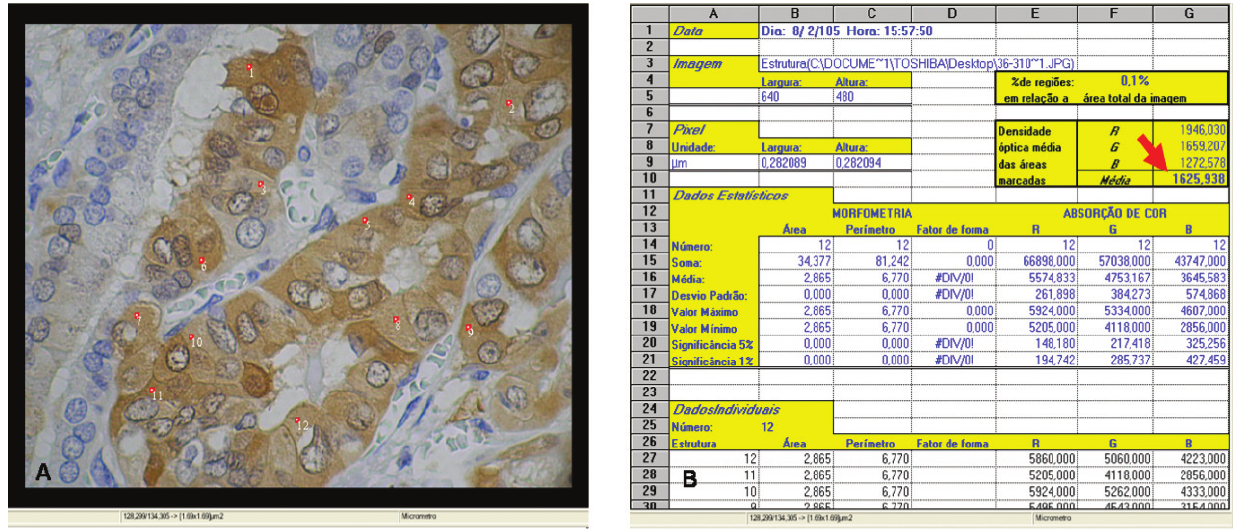
Figure 2 - ImageLab ® software demonstration. (A) Manual determination of 12 cytoplasmic-labeled areas with peroxidase (red squares); (B) Tables showing the results, the arrow indicates the optic density of the total selected area.